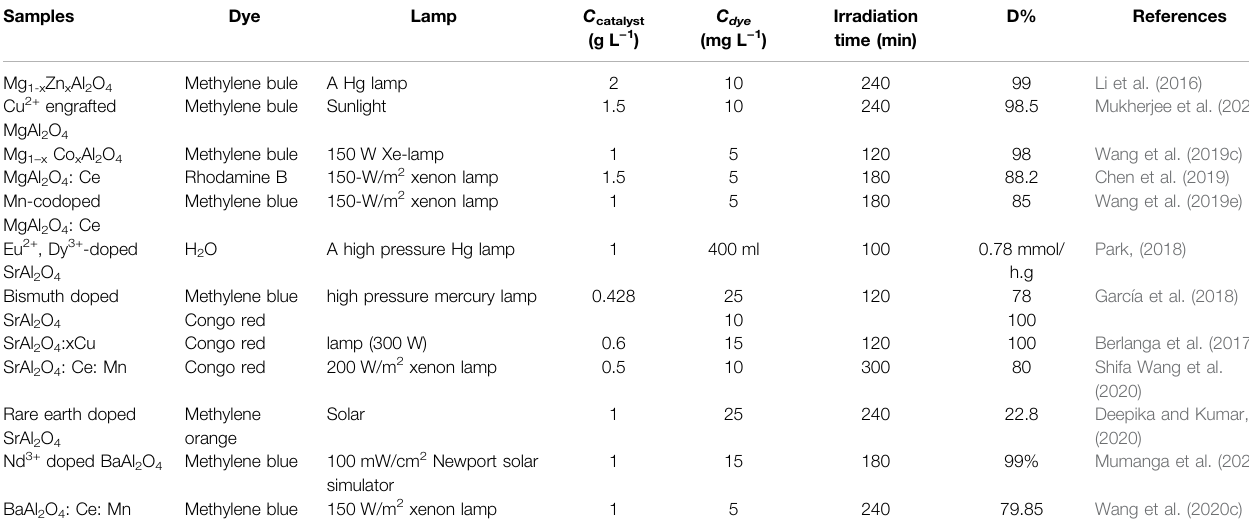
TABLE 3 | The photocatalytic activity of metal ion doped MAl 2 O 4 (M = Mg, Sr, and Ba) photocatalyst. Samples